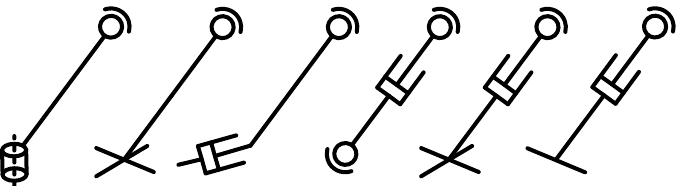
Figure 5. The central branch scheme. The black column and line represents the rotating pair. The black circle represents the ball joint. The black square represents the mobile pair.